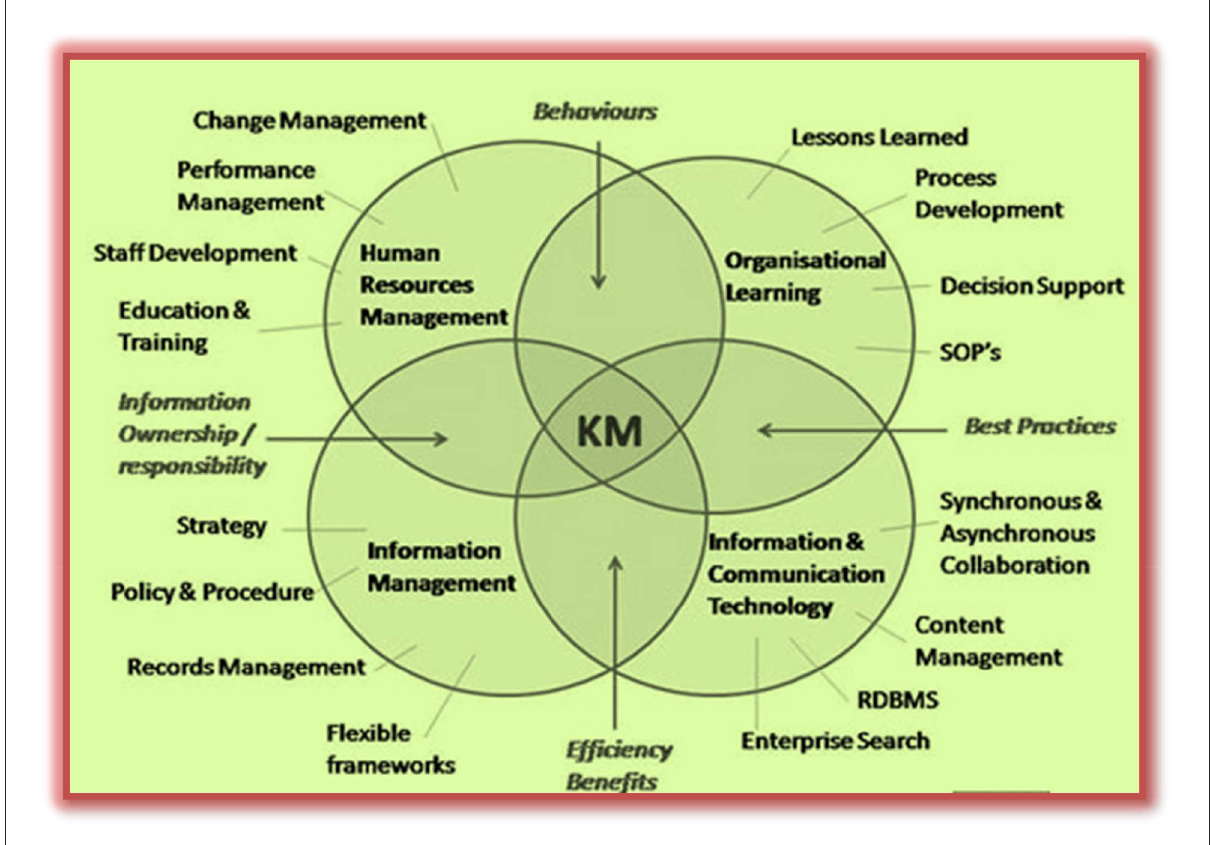
FIGURE5 The link between HR and KM activities (source: authors, based on Garavan et al., 2001; Maier, 2002; Maier and Hädrich,